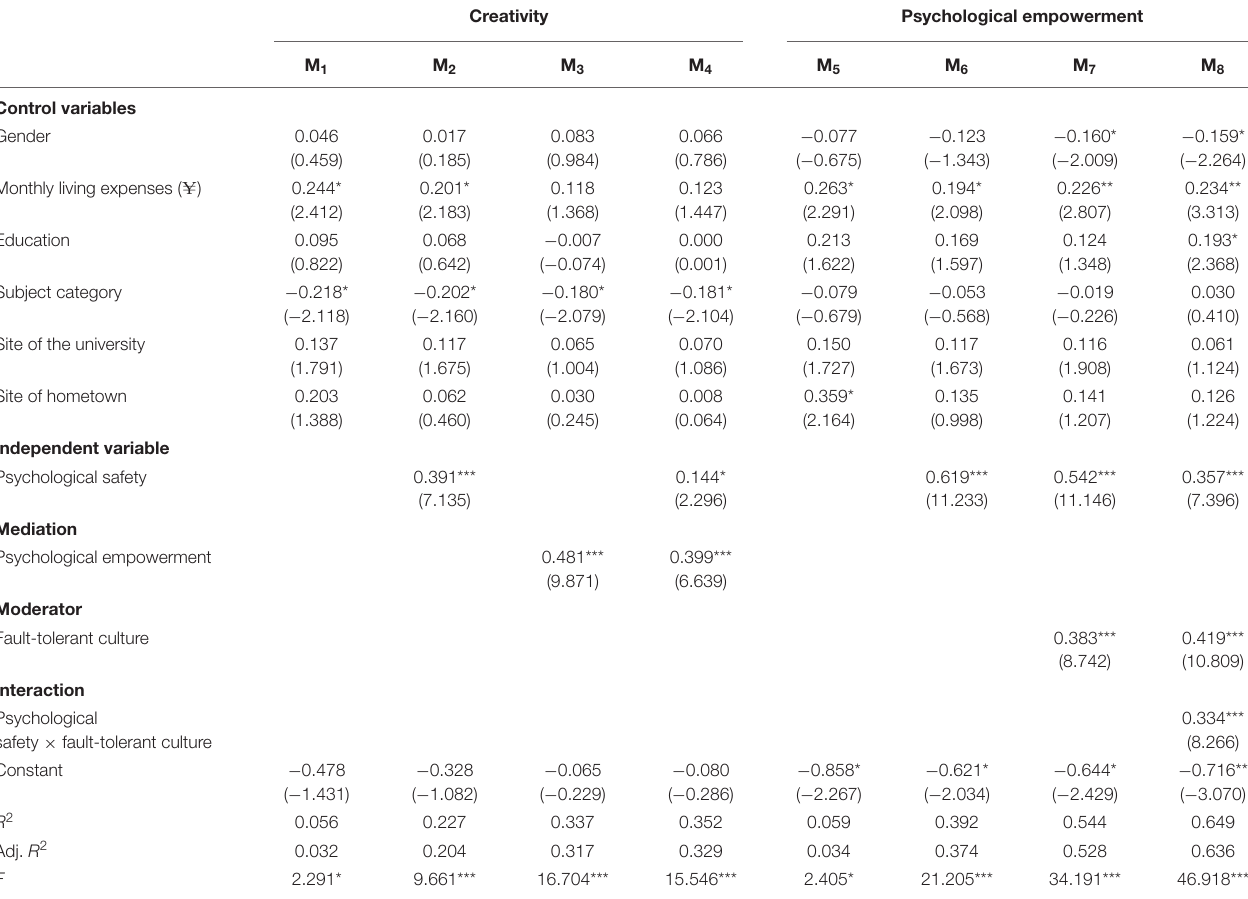
TABLE 5 | Regression analysis